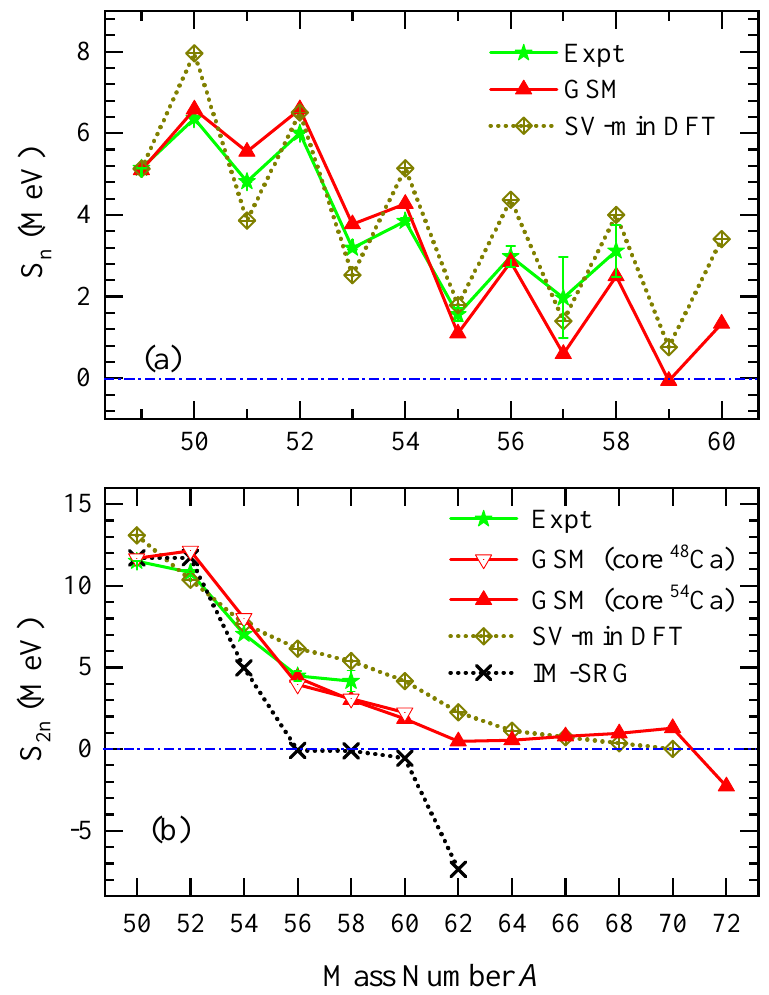
Figure 8. Calculated one-neutron separation energies S n ( a ) and two-neutron separation energies S 2 n ( b ), compared with data [78,92], and calculations obtained with SV-min density-functional theory (DFT) [93] and multireference IM-SRG ( S 2 n only) [94]. The S n calculations end at 60 Ca because odd isotopes heavier than 60 Ca become unbound in our GSM calculations (with permissions from Ref.